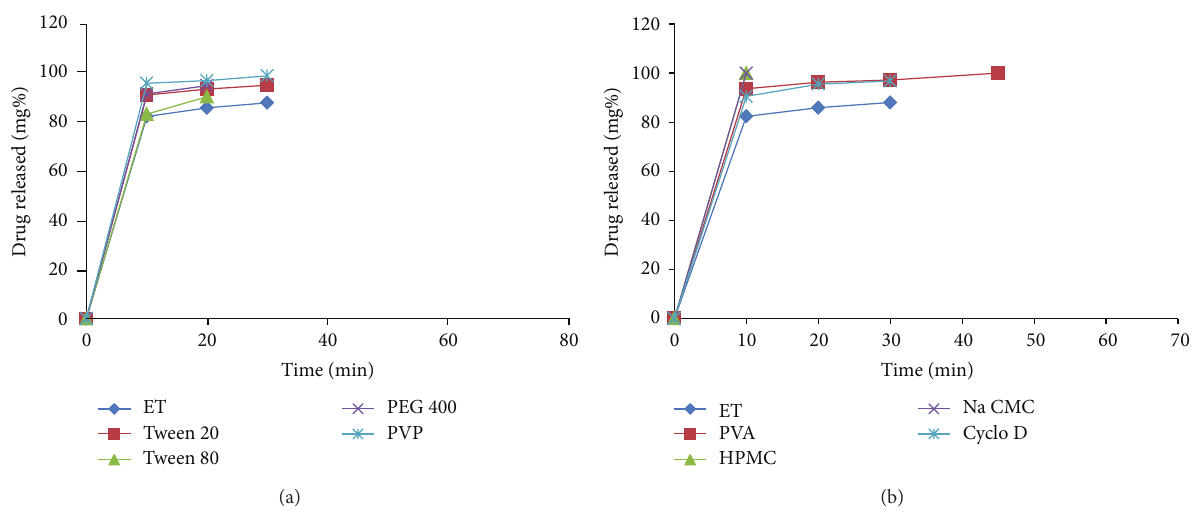
Figure6:(a)DissolutionprofilesofETnanosuspensionspreparedbyantisolventmethodinphosphatebufferpH6.8. 𝑃 = 0.993 notsignificant one-way ANOVA 𝑃 = 0.001 significant two-way ANOVA. (b) Dissolution profiles of ET nanosuspensions prepared by antisolvent method in phosphate buffer pH 6.8. Not significant one way ANOVA but significant two-way ANOVA 𝑃 < 0.001